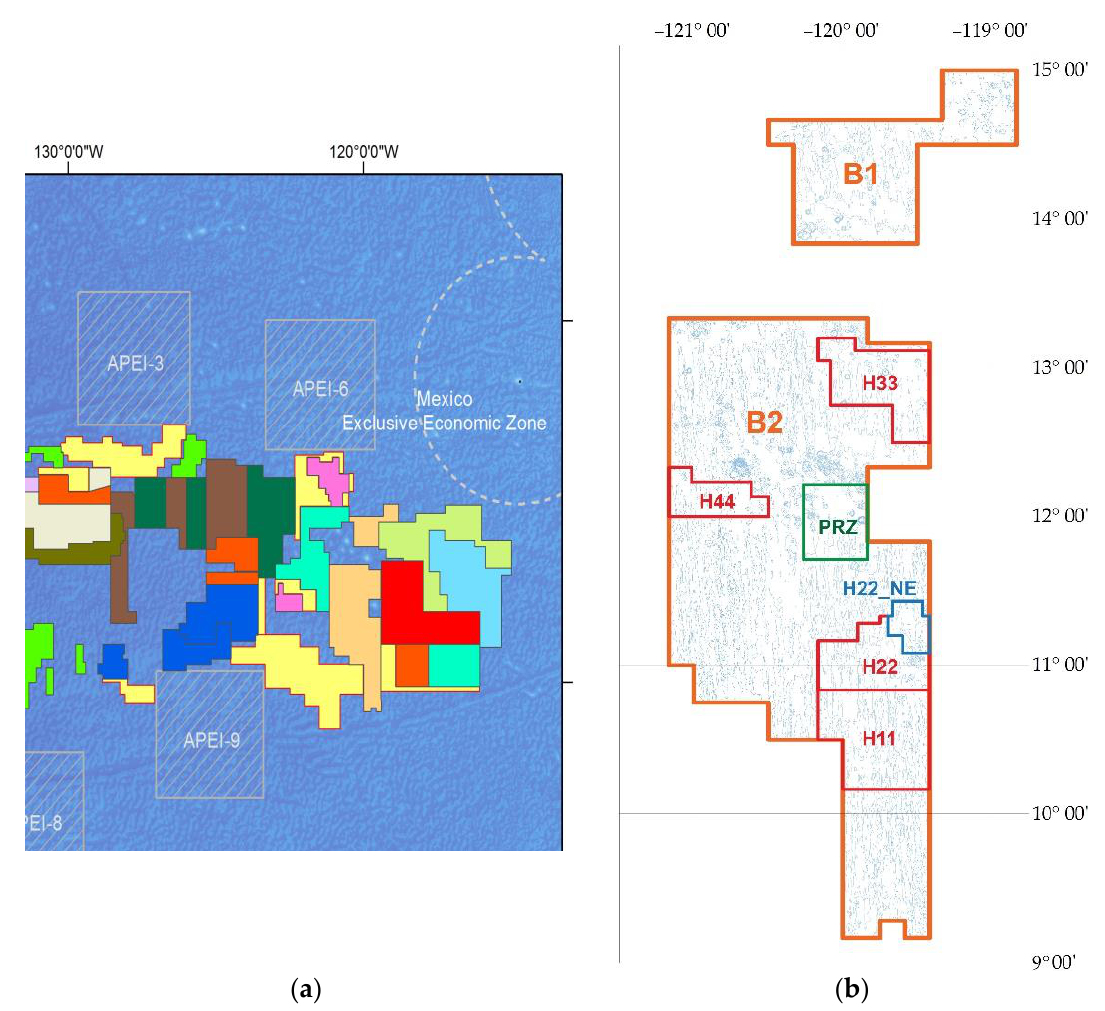
Figure 4. Exploration and exploitable blocks included in the IOM resource estimation ( b ), related to the International Seabed Authority exploration areas for polymetallic nodules ( a ) (source: www.isa.org.jm; accessed on 7 January 2021).